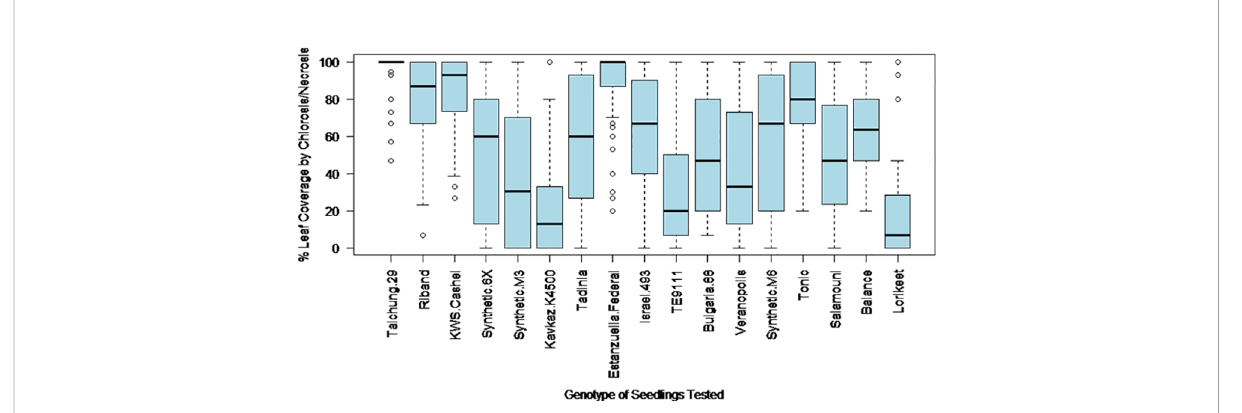
FIGURE 1 The variation in leaf coverage by chlorosis and necrosis induced by different Z. tritici isolates as observed at 28 days post inoculation on each of the 17 studied wheat